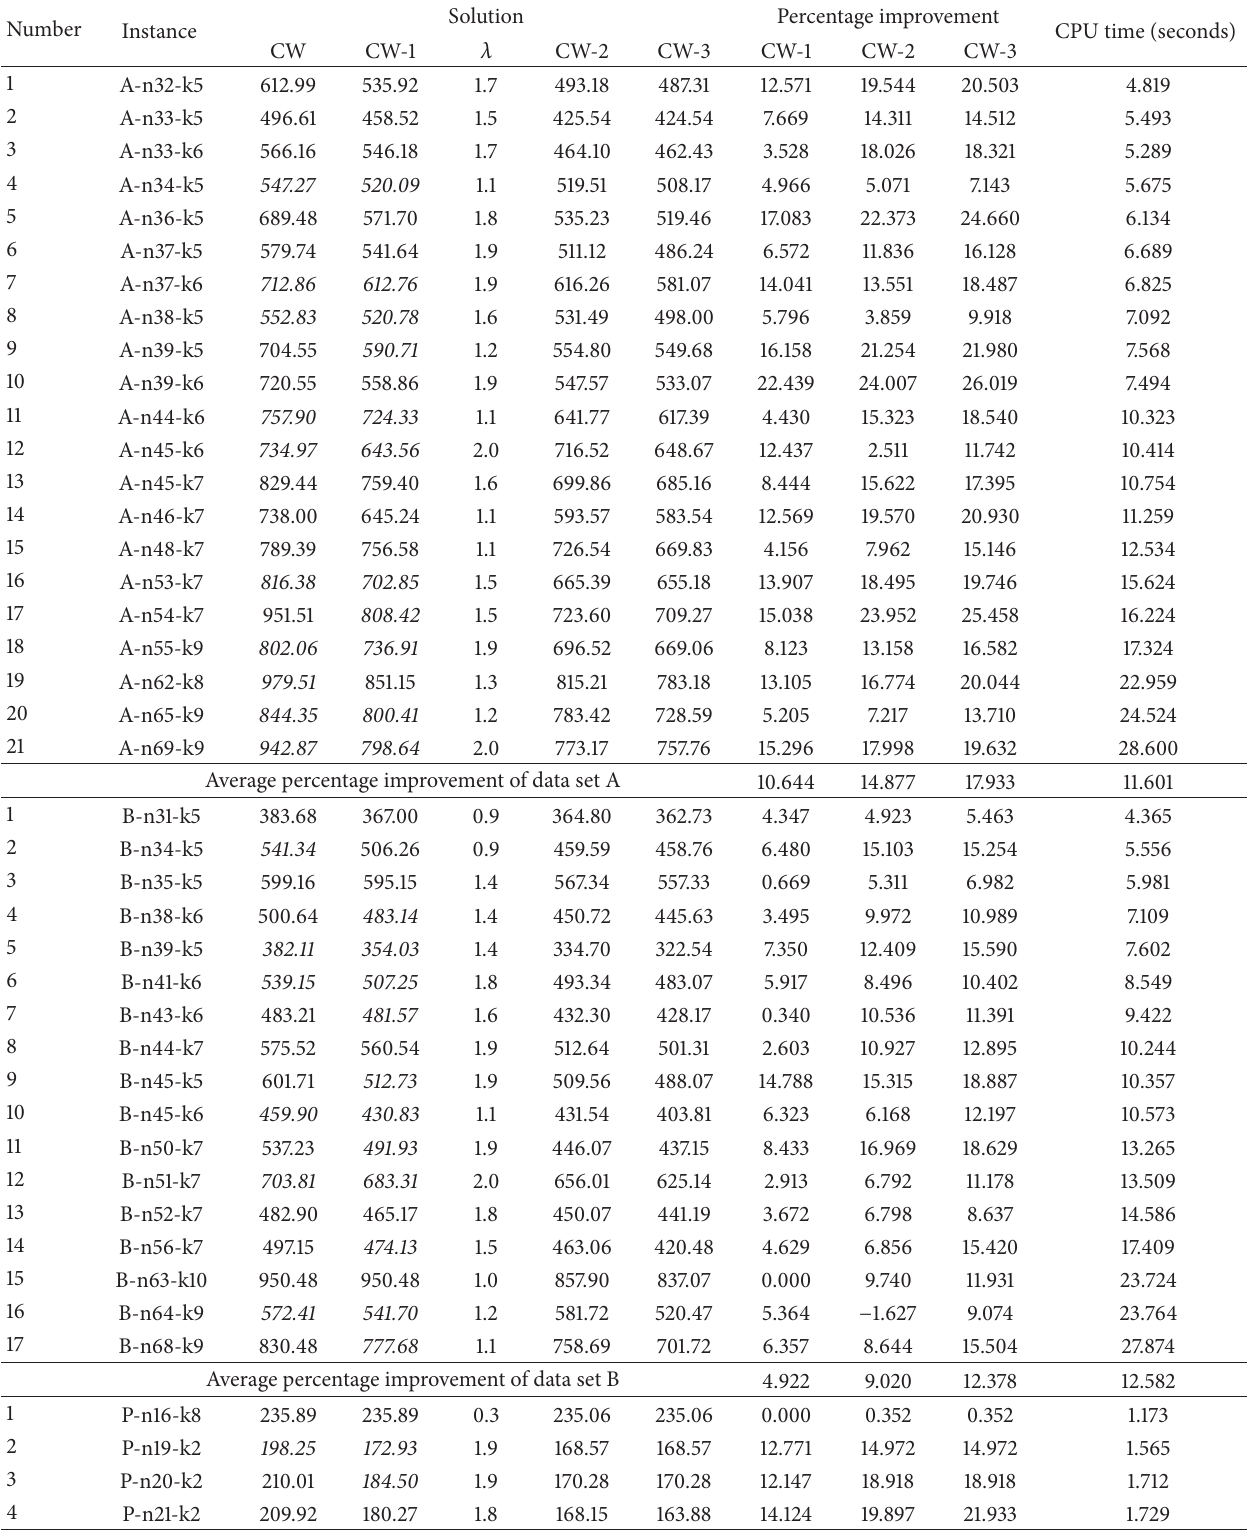
Table 3: Computational results between the proposed CW and CW for data sets A, B, P, E, C, and